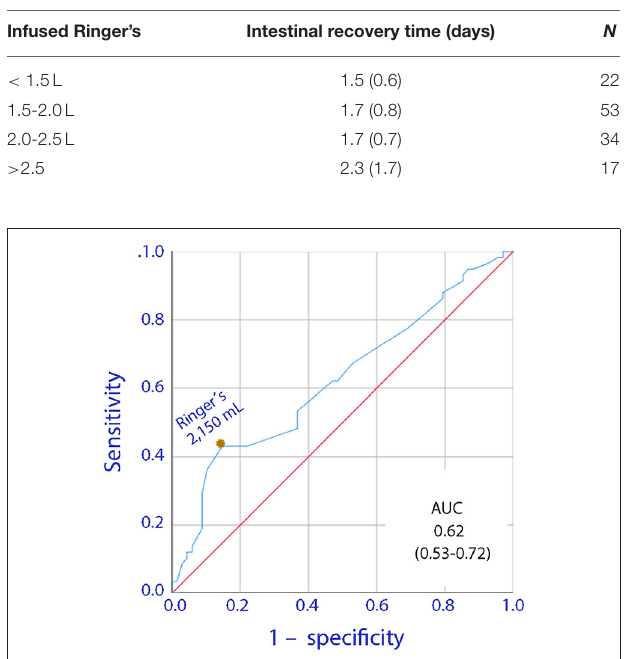
FIGURE 2 | Receiver Operating Curve (ROC) for the relationship between the volume of infused lactated Ringer’s during surgery and a postoperative gastrointestinal recovery time of 2 days or